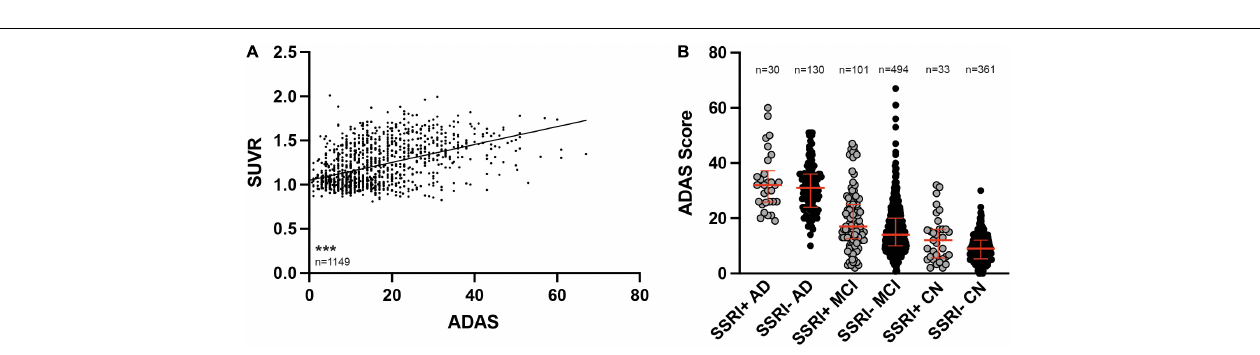
FIGURE 4 | Follow up. (A) Differences of SUVR between follow-up and baseline PET did not show significant differences between SSRI-treated and untreated subjects (Mann–Whitney U test). (B) Differences of ADAS between follow-up and baseline examination did not show significant differences between SSRI-treated and untreated subjects (Mann–Whitney U test). Red bars represent median ± interquartile range.